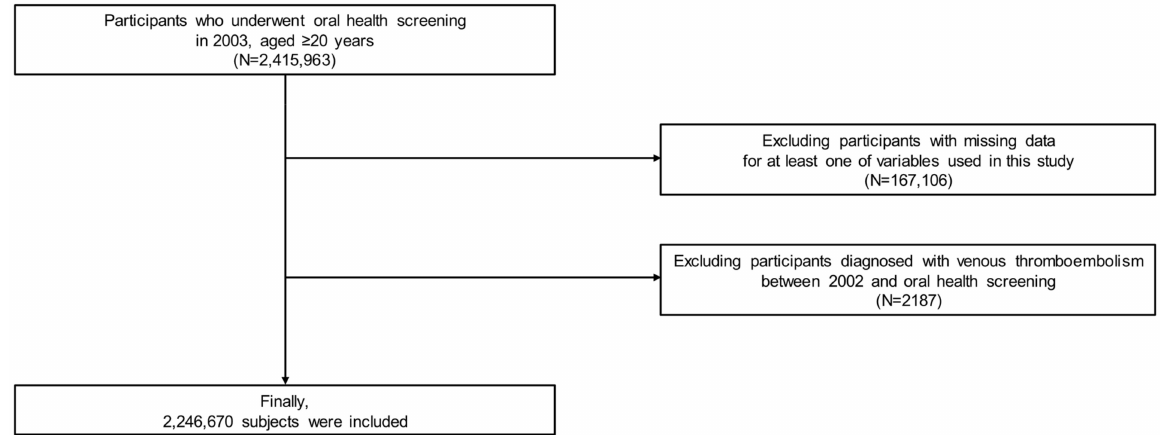
Figure 1. Flow chart of study